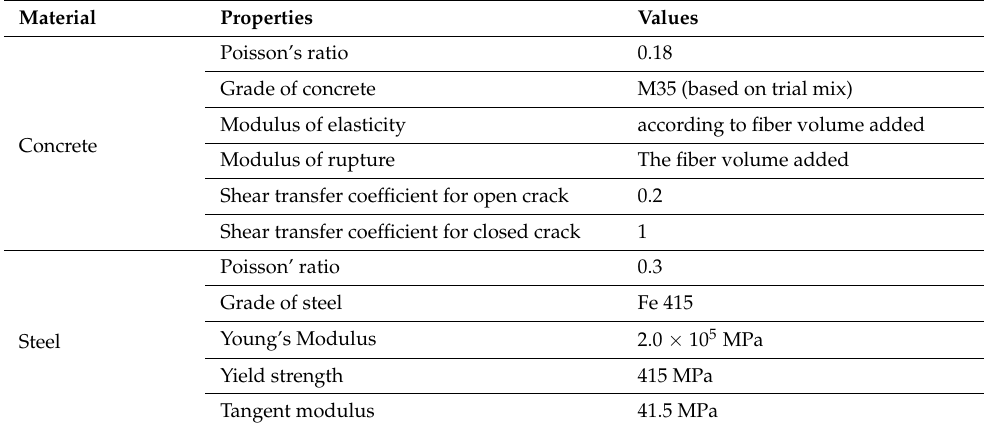
Table 7. The material